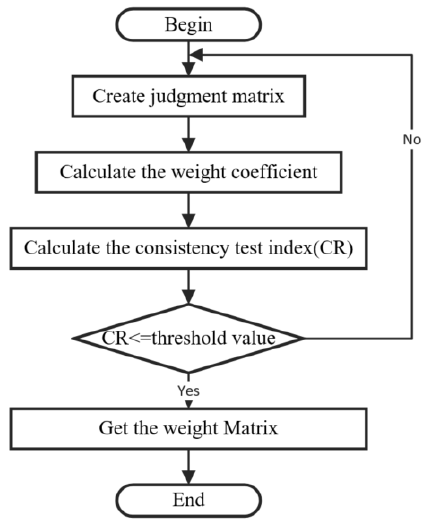
Figure 2. Execution process of AHP. For the judgment process, the priorities of the two indicators are shown in Table 2. B i and B j represent the impact of the i th and j th indexes, respectively. The B i /B j becomes larger with the importance of the i th index increasing relative to the j th index